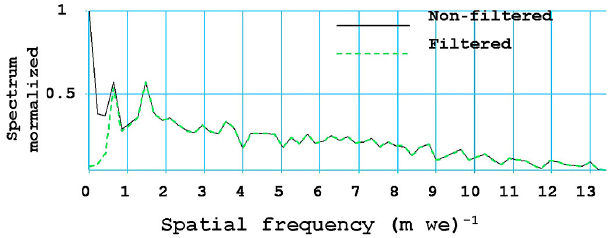
Figure 4. Normalized spectra as a function of the spatial fre- quency of the NO − concentration depth profile after resampling 3 (spline, 2048 samples) and thresholding. Black line: non-filtered. Green line: filtered by high-pass filtering (cut-off frequency = 0 . 5 ( mwe ) − 1